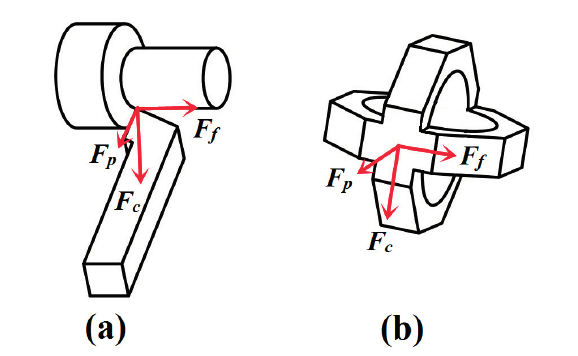
Figure 1. ( a ) Triaxial cutting force components; ( b ) Structure of two mutual-perpendicular octagonal